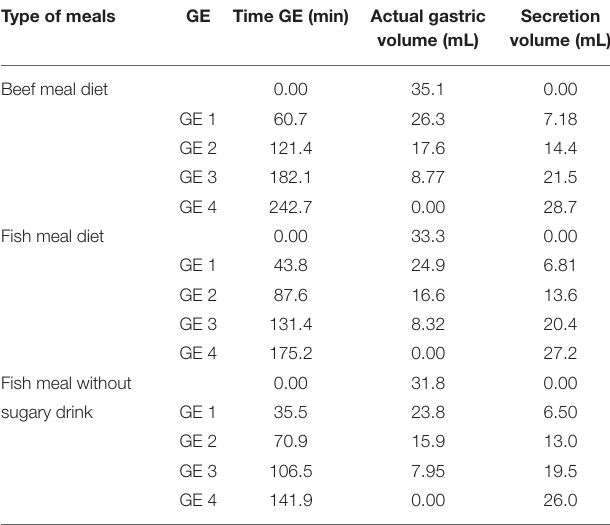
TABLE 1 | Overview of sampling times and volumes during the semi-dynamic in vitro gastric digestion in beef meal, fish meal, and fish meal without sugary drink